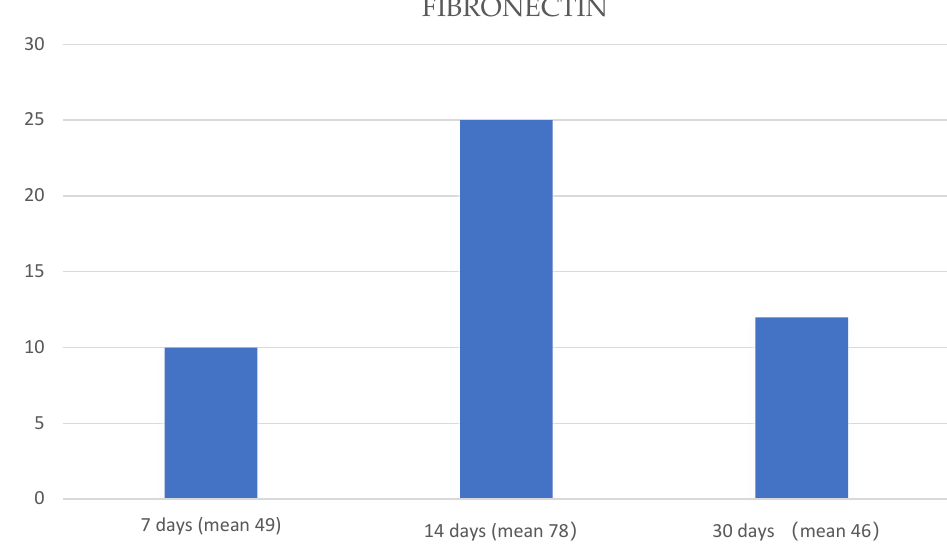
Figure 3. Compound panel of immunofluorescence reaction pictures that show VEGF staining pattern in human dental pulp after 7 ( A ), 14 ( C ) and 30 ( E ) days after pre-calibrated force application and the corresponding transmitted light observations ( B , D , F ). The following magnifications have been used: 10× (A, B), 20× ( C , D , E , F ). The mean of each protein expression, at 7, 14 and 30 days, respectively, was used to create graphics (Figures 4–6).